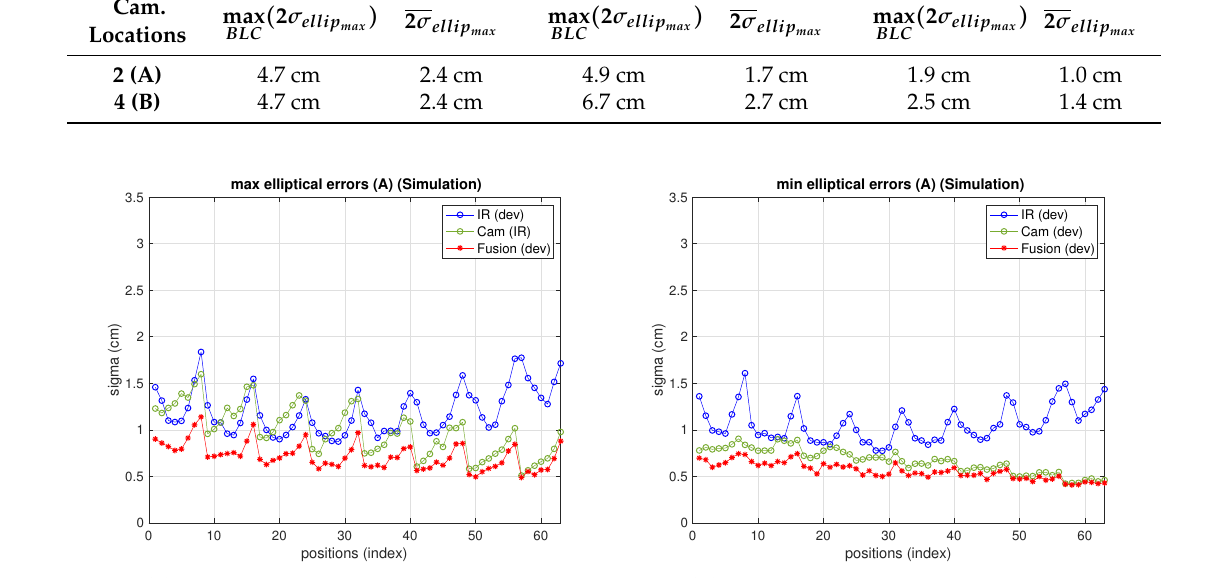
Table 6. Summary of precision for IR, camera and fusion (real measurements). IR Camera Fusion Cam.